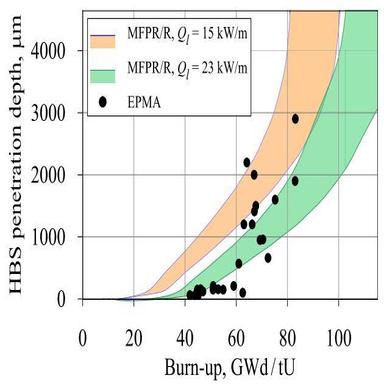
Uncertainty bands for HBS penetration depth calculated as a function of burnup in comparison with the EPMA measurements.